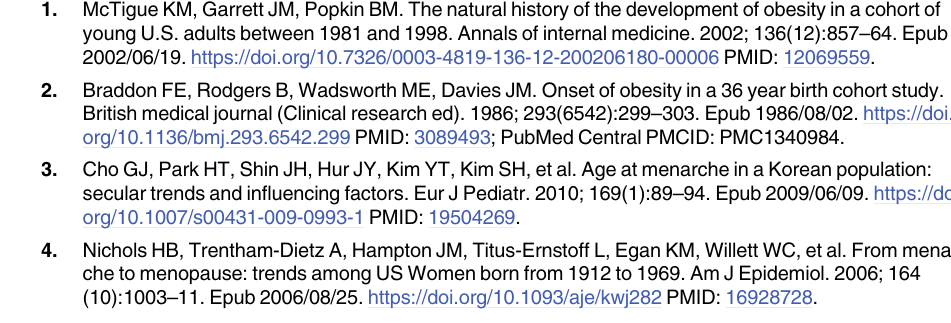
S4 Table. SNPs replicated with AAM in the Korean Genome and Epidemiology Study